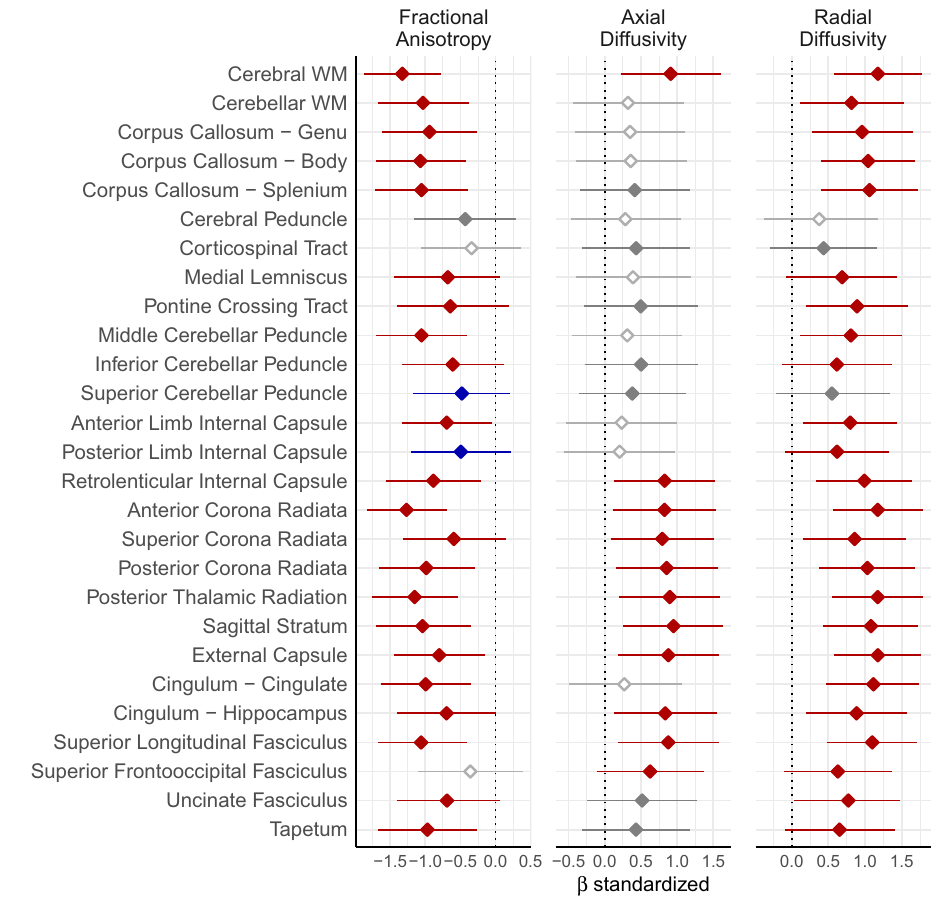
Figure 1. Group differences in WM microstructure measures. Fractional anisotropy values (left panel) were lower in DM1 relative to healthy adults on most regions evaluated (colored estimates), indicating reduced WM integrity. Axial and radial diffusivity (middle and right panels, respectively) were higher in DM1 relative to healthy adults, indicating decreased directional restriction of water molecules in DM1-affected WM. Red indicates volumes of interest (VOIs) where FDR-corrected p < 0.05, blue indicates FDR-corrected p < 0.1, gray indicates uncorrected p < 0.05, and white indicates uncorrected p > 0.05. Error bars represent the 99.99% confidence limits, which approximates the FDR-corrected p = 0.0081. Data were plotted using R (version 3.5.0, https ://www.r-proje ct.org/) 25